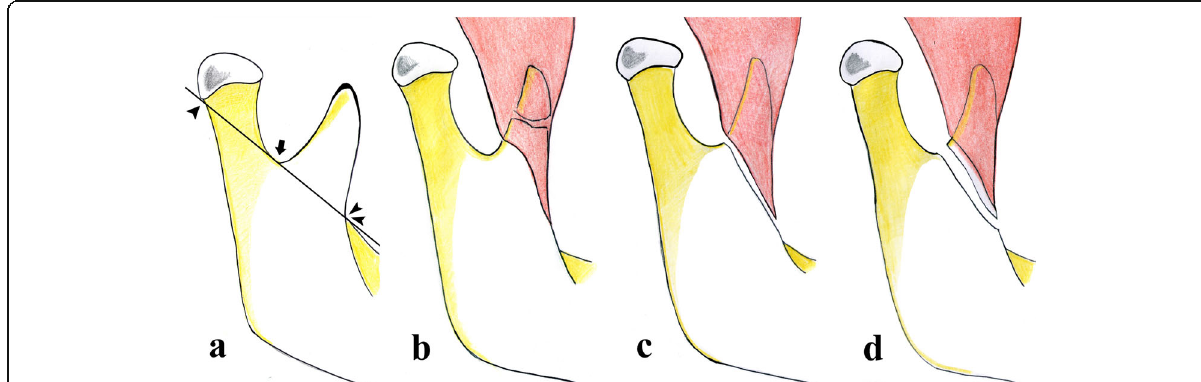
Fig. 8 Coronoid process fracture. a A straight line passing through the deepest central point of the sigmoid notch (arrow) is traced from the lower posterior portion of the condylar head (single arrowhead) to the anterior edge of the mandibular ramus (double arrowhead). The bone portion included between the arrow and double arrowhead represents the coronoid process. b Coronoid process apex fracture. The fracture is fully included in the temporal muscle. Bone fragment displacement is minimal. c Coronoid process fracture medial to the deepest central point of the sigmoid notch. The fracture approximately originates in the correspondence of the temporal muscle attachment points. d Coronoid process fracture corresponding to the deepest central point of the sigmoid notch. The fracture originates below the temporal